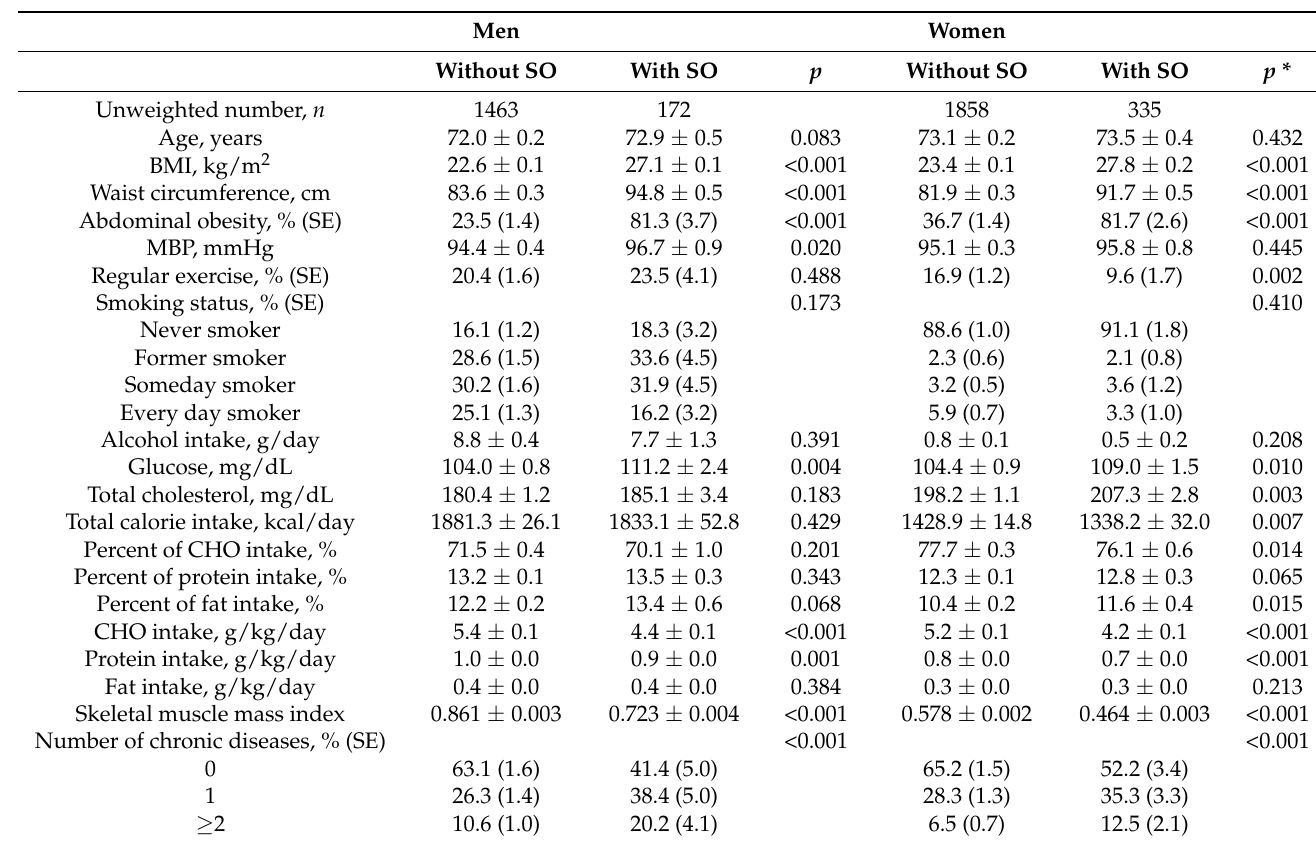
Table 1. Clinical characteristics of the older adults with or without sarcopenic obesity. Men Women Without SO With